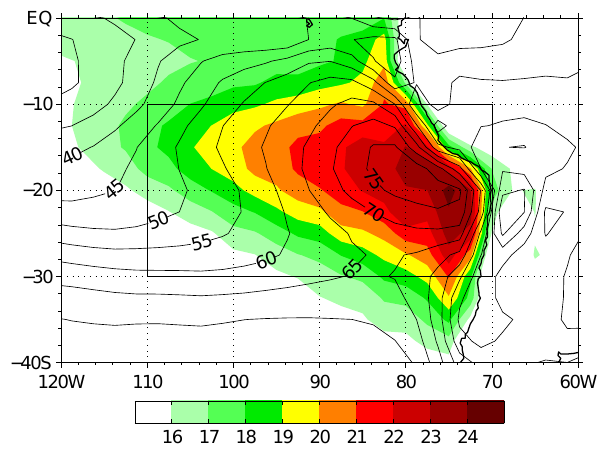
Fig. 1. Long-term climatology (1983–2002) of lower-tropospheric stability (LTS, θ 700 - θ 1000 , shaded, Unit: K) and the adjusted low cloud amount (contour, Unit: %).